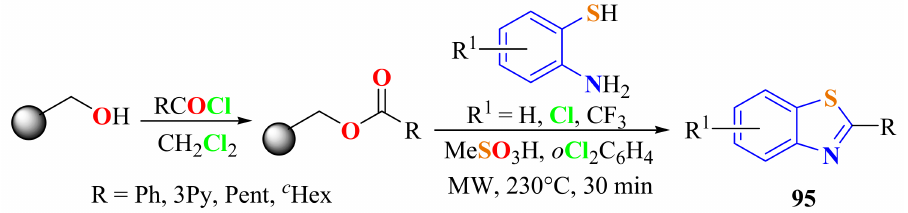
Scheme 77. Condensation of substituted o -ATPs with resin-bound esters in methane sulfonic acid/1,2-dichlorobenzene. Rauf et al., in an efficient and solvent-free one-pot method, condensed ATPs